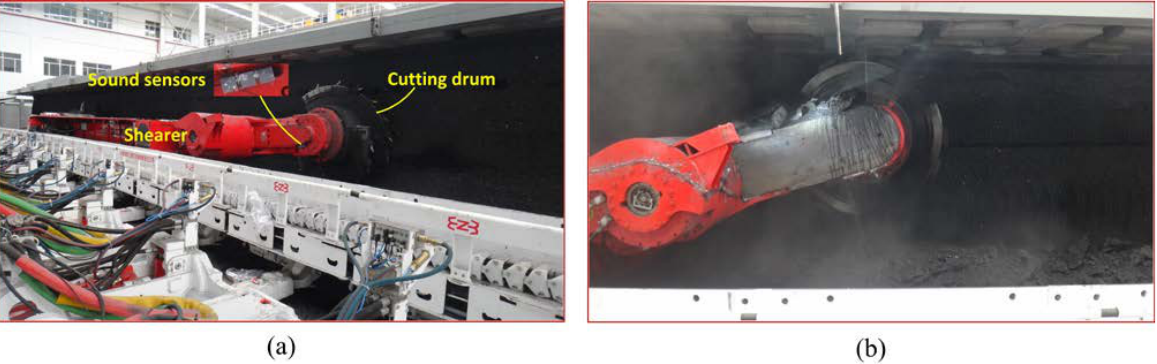
Figure 8. ( a ) Experimental site equipment arrangement; ( b ) Experimental process of coal-rock cut- ting.